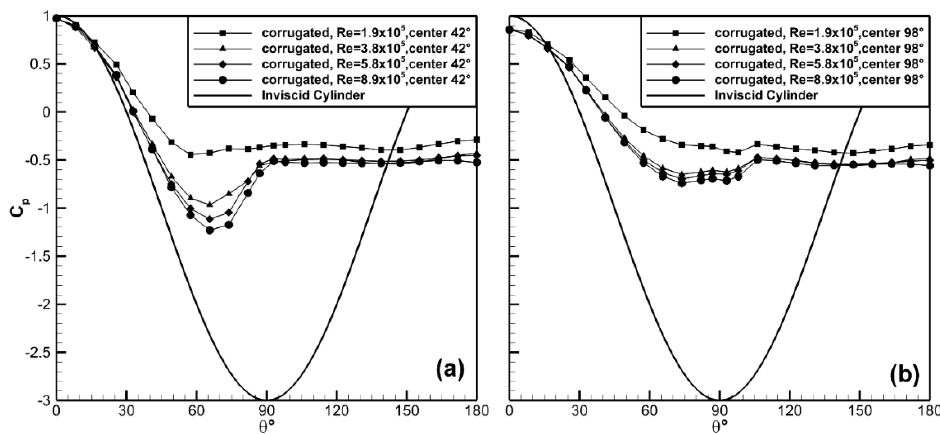
Figure 11. Pressure distributions at ( a ) φ = 42° and ( b ) φ = 98° up the channel wall. Fluids 2020 , 5 , 25